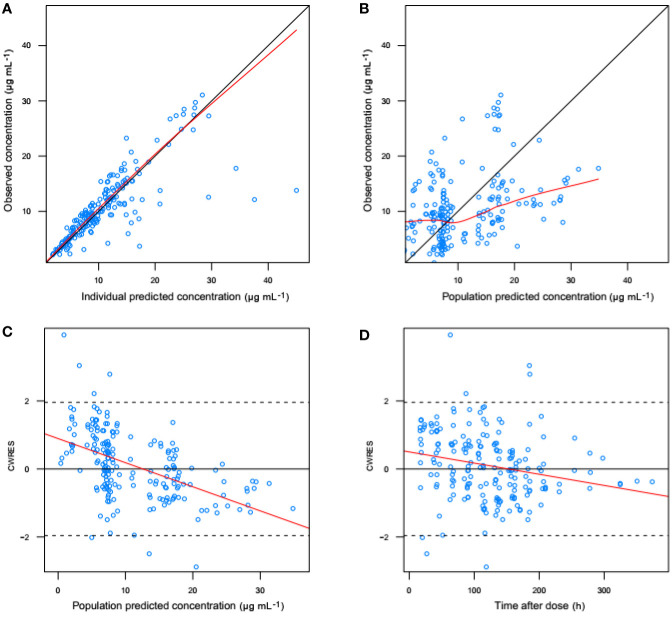
Goodness-of-fit evaluation plots obtained for the basic model. (A) Observed trough plasma concentrations of vancomycin versus individual model predictions of concentrations. Solid line, the line of identity. (B) Observed trough plasma concentrations of vancomycin versus population model predictions of concentrations. Solid line, the line of identity. (C) Conditional weighted residuals (CWRES) versus population predictions of concentration. (D) Conditional weighted residuals versus time after the initial administration of vancomycin posttransplantation.